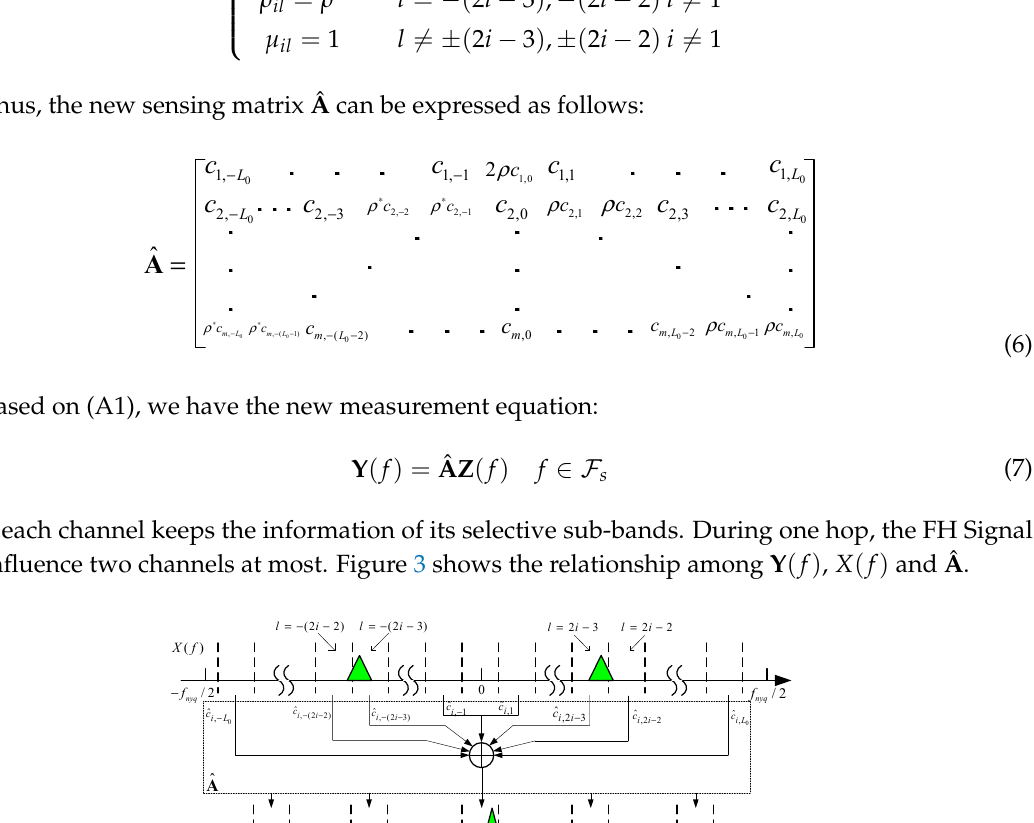
Figure 3. The relationship between ( ) f Y , ( ) X f and ˆ A .